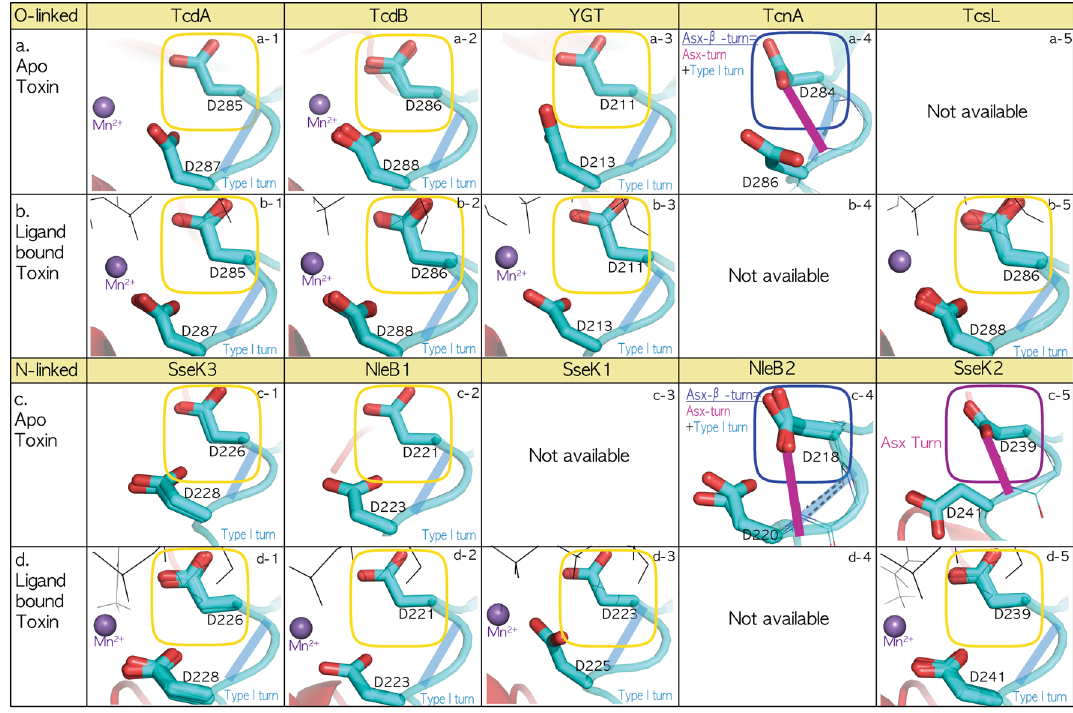
Figure 4. Pincher-like Aspartate Dn in the DxD (Dn-Xn + 1-Dn + 2) motif of bacterial mono-glycosylation toxins. All 51 known structures of O-glycosylation TcdA/B, TcsL, TcnA, and YGT, the N-glycosyltransferase NleB1/2, and SseK1/2/3 toxins in the asymmetric unit (Table 2) are separated into each toxin-related ligand- binding from apoO-glycosylation in row ( a ), ligand-bound O-glycosylation in row ( b ), apo N-glycosylation in row ( c ) and ligand-bound N-glycosylation in row d. All ligand-bound toxins have a Type-I-turn and a backbone C10 H-bond network, for the first aspartate side-chain in the DxD motif to freely bind the cofactor Mn 2+ in rows ( b ) and ( d ). Except for the three toxins in apo TcnA, SseK2, and the NleB2 toxins ( a4 , c4/5 ), all glycosylation toxins retain the Type-I-turn in the DxD motif regardless of O-/N-linked glycosylation (cyan colored). The type-I-turn in the apo TcdA/B DxD motif as the backbone C10 H-bond network permits the first catalytic aspartate to coordinate with Mn 2+ (3SS1, a1 and 5UQT, a2 ). Unlike the first aspartate sidechain of the Apo SseK2 DxD motif in only the Asx-turn (5H61, c5 ), both TcnA (2VK9, a4 ) and NleB2 (6AI4, c4 ) DxD motifs are tightly tied by double C10 H-bond networks, an Asx-turn, twice intertwined with a Type-I-turn (cyan colored), and an Asx-turn (purple